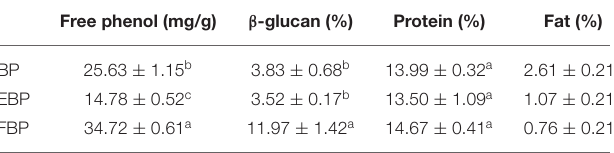
TABLE 2 | Main nutritional and function component of BP, EBP, and FBP. Free phenol (mg/g) β -glucan (%) Protein (%) Fat